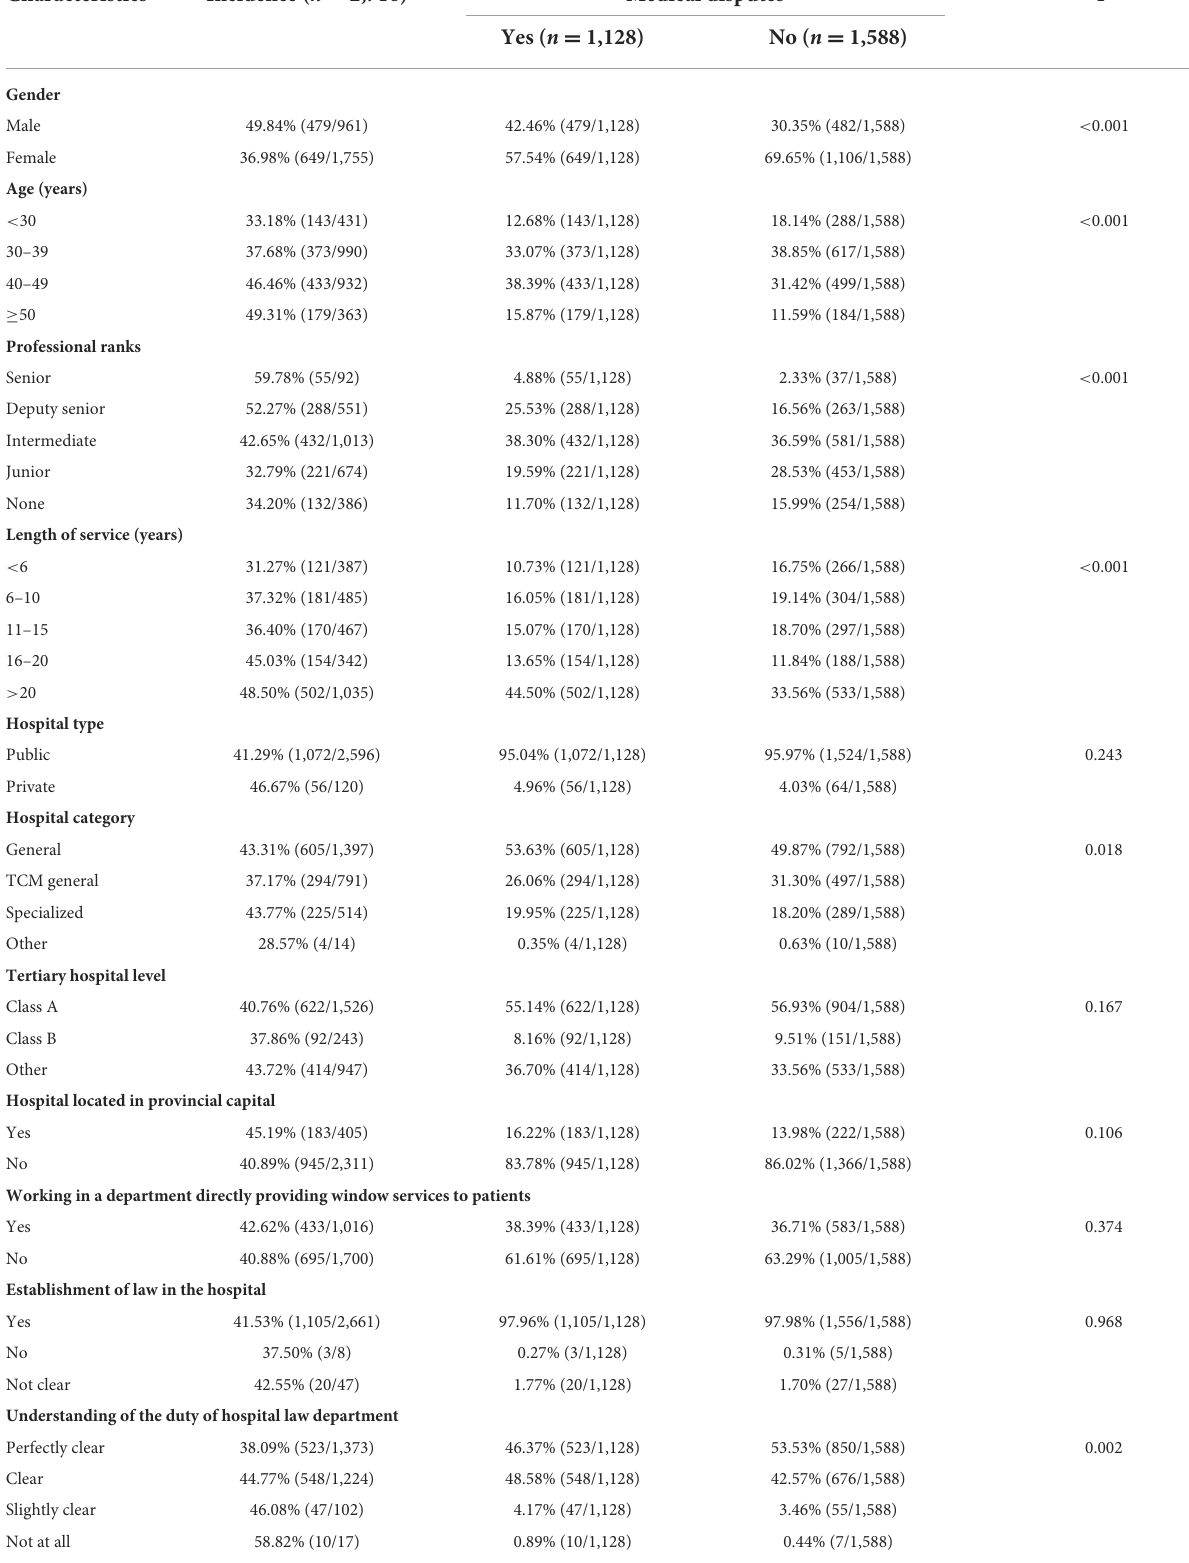
TABLE 2 Comparison of characteristics between administrators with and without medical disputes.